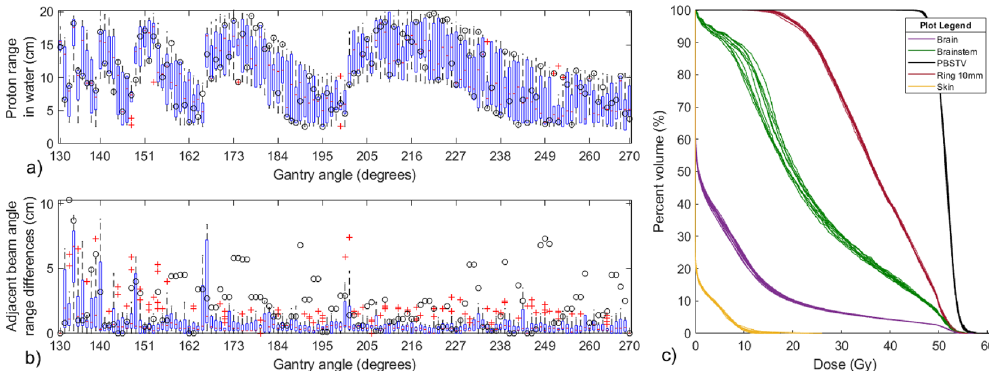
Figure 5. ( a ) Histogram of proton range layers for each gantry angle control point among 10 independently optimized treatment plans. The proton beam range for each gantry angle control point is plotted ( ◦ ) for a single planning case. ( b ) The distribution of adjacent energy layers among the 10 treatment plans is plotted below for each gantry angle (see text for details). The minimum proton range difference between adjacent beam angles is shown for a single case, ( ◦ ) . ( c ) An overlay of 10 DVH profiles resulting from the dose distribution optimized from ten independent genetic proton arc